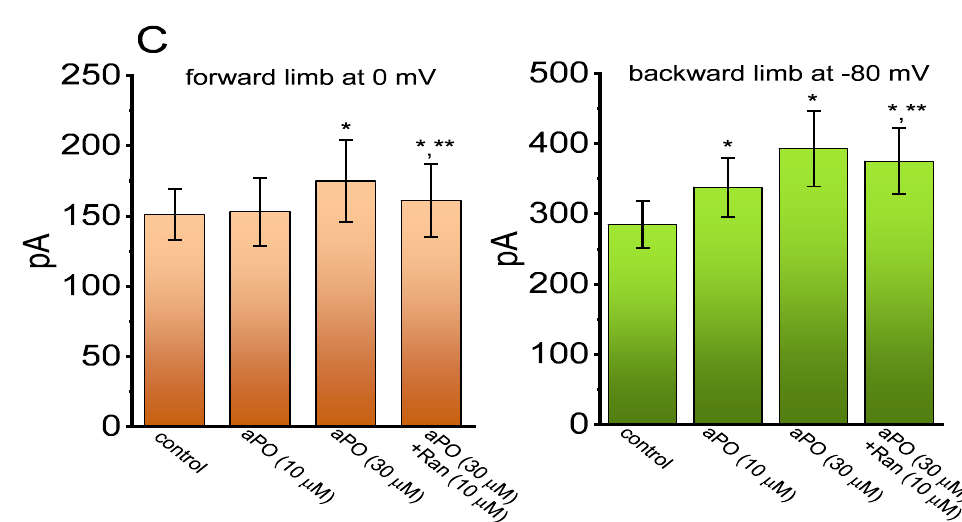
Figure 6. Effect of aPO on voltage-dependent hysteresis (Vhys) of persistent I Na (I Na(P) ) activated by isosceles-triangular ramp pulses with varying ramp duration in GH 3 cells. In this series of whole-cell current recordings, we voltage-clamped the tested cell at − 80 mV and the isosceles-triangular ramp voltage with varying duration of 0.4 to 3.2 s (i.e., ramp speed of ± 0.1 to 0.8 mV/ms) to activate I Na(P) in response to the forward (i.e., ascending from − 110 to +50 mV) and backward (descending from +50 to − 110 mV) that was thereafter applied to it. ( A ) Representative I Na(P) traces obtained in the control period (upper, aPO was not present), and during cell exposure to 10 µ M aPO (lower). The uppermost part shows varying durations of isosceles-triangular ramp pulse applied. Of notice, the presence of aPO can augment the I Na(P) amplitude elicited by the upsloping and downsloping limbs of the triangular ramp. ( B ) Representative instantaneous I-V relation of I Na(P) in response to isosceles-triangular ramp pulse (the voltage between − 100 and +50 mV) with a duration of 3.2 s (as indicated in the left side of panel ( B )). Current trace in the left side is control, while that in the right side was acquired from the presence of 10 µ M aPO . The dashed arrows in the left side show the direction of I Na(P) trajectory in which time passes during the elicitation by the upright isosceles-triangular ramp pulse. Of interest, a striking figure-of-eight (or infinity-shaped: ∞ ) exists in the Vhys trajectory responding to the triangular ramp. ( C ) Summary bar graph demonstrating the effect of aPO and aPO plus Ran on I Na(P) amplitude activated by the upsloping and downsloping limbs of 3.2-s triangular ramp pulse (mean ± SEM; n = 8 for each bar). Current amplitudes in the left side were taken at the level of 0 mV in situations where the 1.6-s ascending (upsloping) end of the triangular pulse was delivered to elicit I Na(P) (i.e., high-threshold I Na(P) , while those in the right side (i.e., low-threshold I Na(P) ) was at − 80 mV during the descending (downsloping) end of the pulse. Current amplitude measured is illustrated in the absolute value. Data analyses were performed by ANOVA-1 ( p < 0.05). * Significantly different from controls ( p < 0.05) and ** significantly different from aPO (30 µ M) alone groups ( p < 0.05).